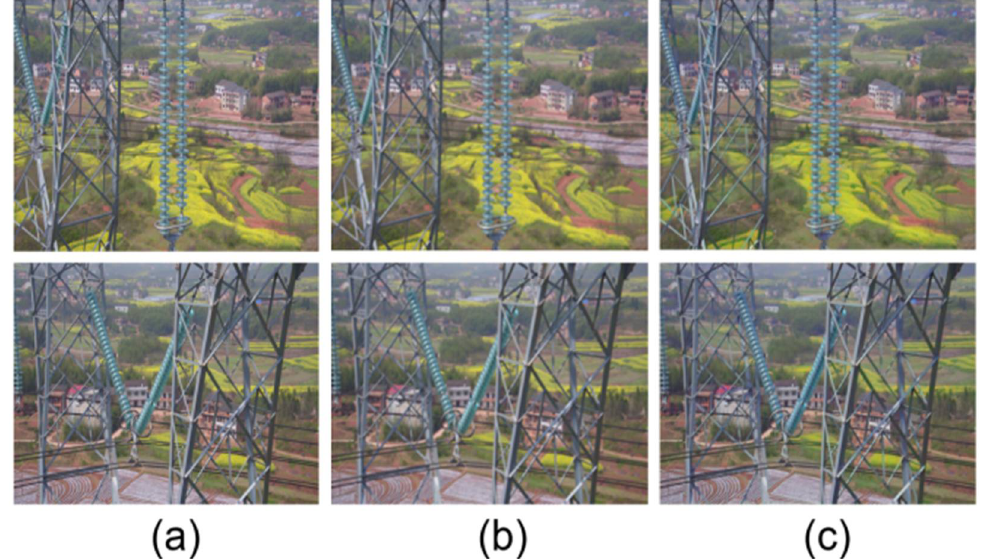
Figure 7. Compared illustration of super-resolution and bicubic interpolation. ( a ) are the original images. ( b ) are the high-resolution images which resize from the low-resolution images (256 × 192). ( c ) are the super-resolution images which are reconstructed by SRGAN.